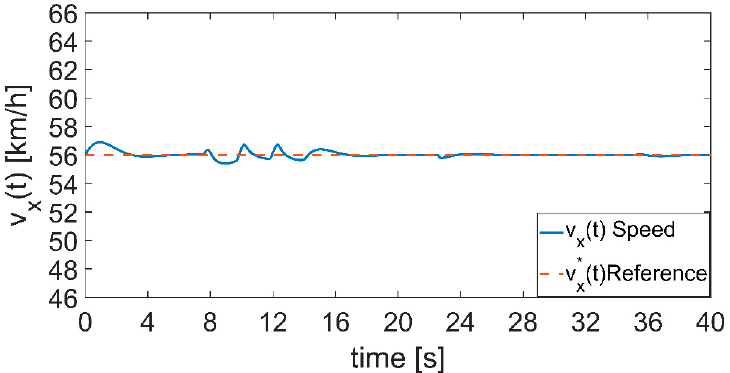
Figure 21. Bending on Low-Friction Patch: speed tracking v x .